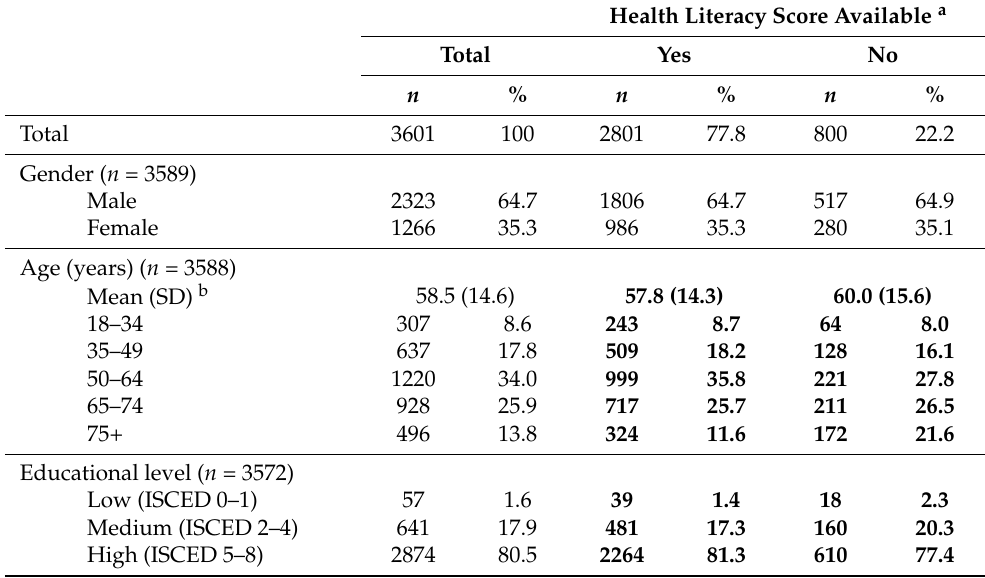
Table 1. Sample characteristics, total and stratified by availability of health literacy score ( n =